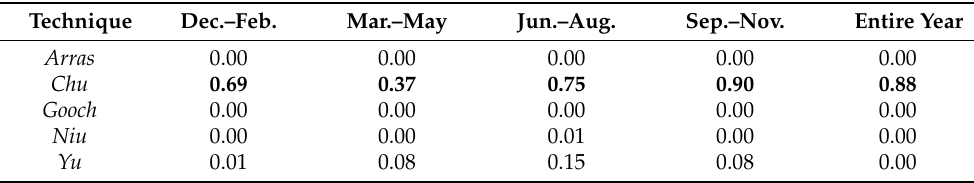
Figure 6. Same as Figure 3, but for fbEs ≥ 3 MHz. ( a ) December, January, and February 2010–2017. ( b ) June, July, and August 2010–2017. Table 4. Digisonde and GPS-RO mean statistical similarity for fbEs ≥ 3 MHz. Bold values highlight the largest statistical similarity for each